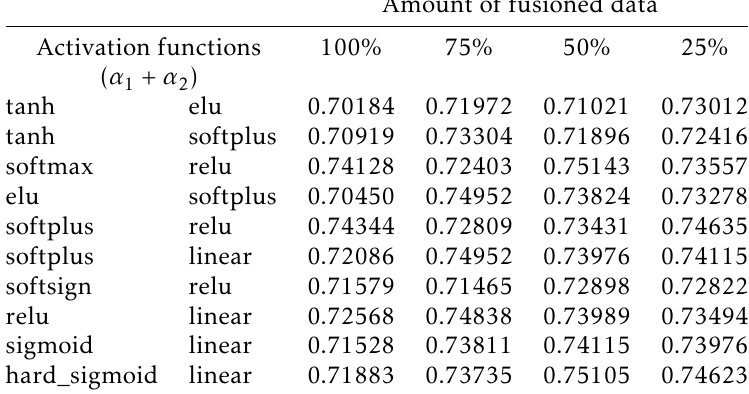
Table 2. Tuples of the ten highest activity recognition model results for Subject 1, which benchmark accuracy is 0.59455.